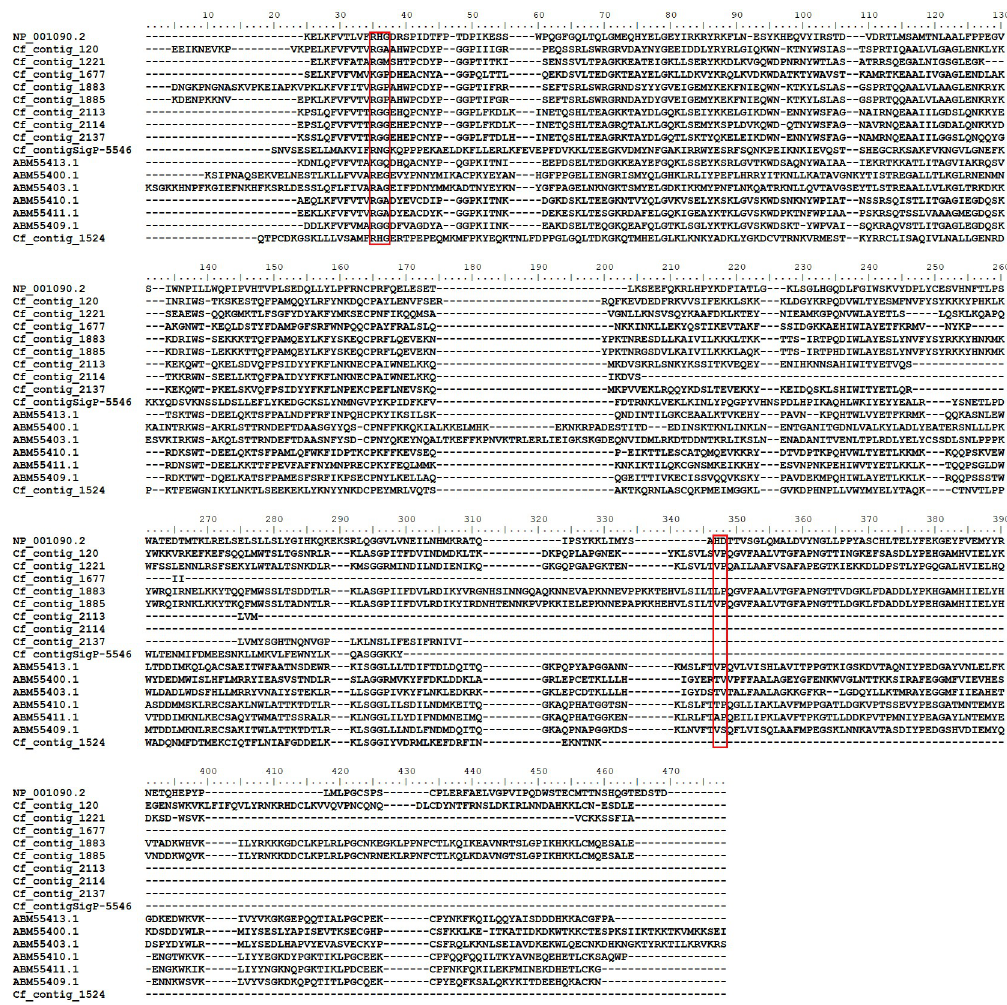
Fig 1. Amino acid alignment of members of the FS-H protein family. Sequences from C . felis salivary glands (Cf_contig_XXXX) detected by LC-MS analysis with previously deposited identified FS-H members from the rat flea X . cheopis (Xc_XXX and ABMXXXXX) and scorpion toxins from Centruroides noxius (sp|P15223), Tityus obscurus (sp| H1ZZI4), Mesobuthus martensii (sp|P15228), Leiurus hebraeus (sp|P0C5I9) and Rhopalurus junceus (sp|E7CLP2). The conserved cysteine residues are shaded in